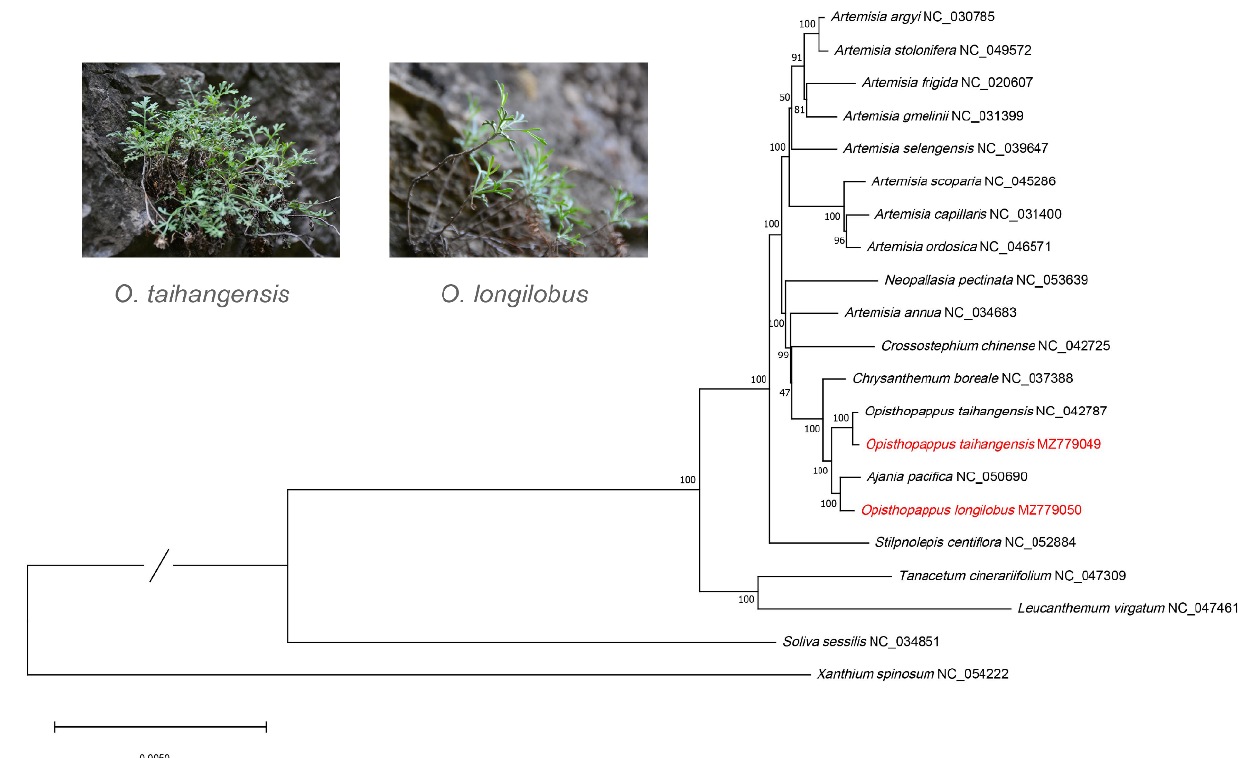
Figure 4. Maximum likelihood (ML) phylogenetic tree based on chloroplast genomes of subtribe Chrysantheminae. The top left corner shows a comparison of the habitat maps of the two species.